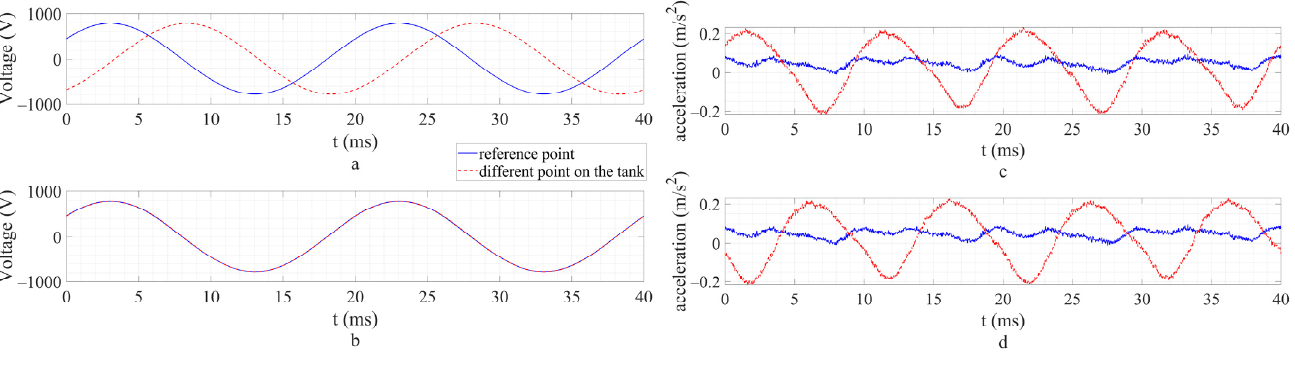
Figure 4. Voltage and acceleration signals of the reference point and some different points on the tank: ( a , c ) before alignment and ( b , d ) after alignment.